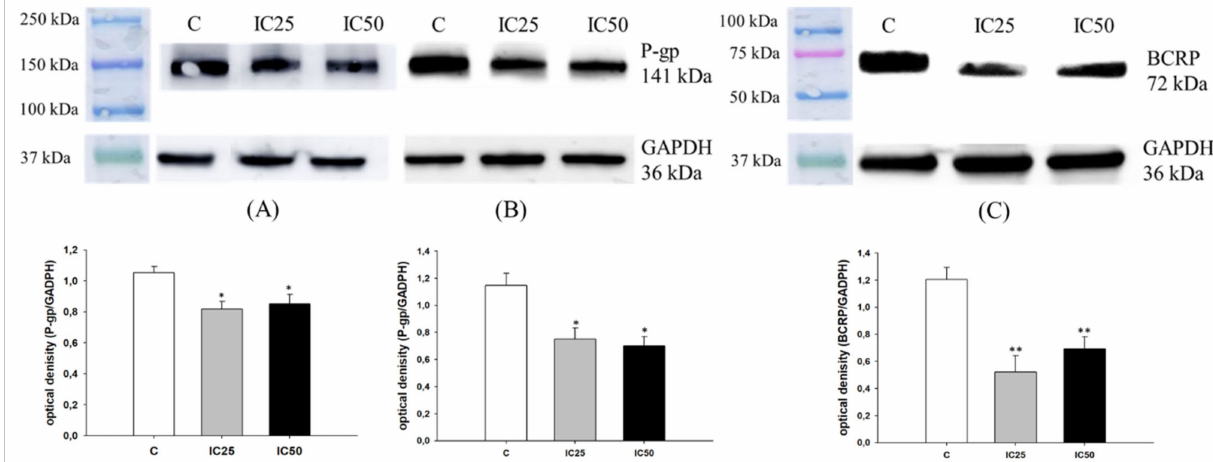
Figure 7. P-gp protein expression analysis in the W1PR1 ( A ), W1PR2 ( B ), and BCRP protein expression analysis W1TR cell line ( C ). Protein lysates were prepared after 72 h of cell culture at piperine concentrations at the IC25 or IC50 along with the control untreated cells ( C ). The cellular proteins were separated using 7% PAGE and transferred to a PVDF membrane, which was then immunoblotted with either primary Ab or HRP-conjugated secondary Ab. A primary anti-GADPH Ab was used as a loading control for the cell lysates. The graphs show the results of the densitometry quantification of the Western blot analysis optical density, which is presented as a P-gp/GADPH ( A , B ) or BCRP/GADPH ( C ) ratio. The values were considered significant at * p < 0.05 and ** p <